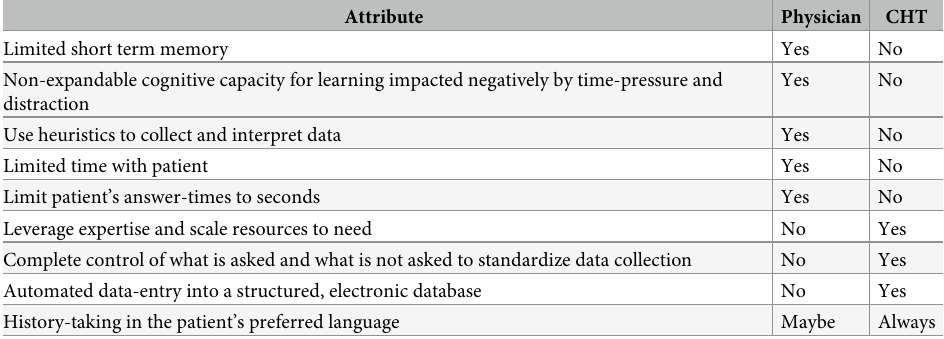
Table 8. Comparison of physician and CHT attributes affecting the completeness, accuracy and bias of data col- lected by each method for history-taking. Attribute Physician CHT Limited short term